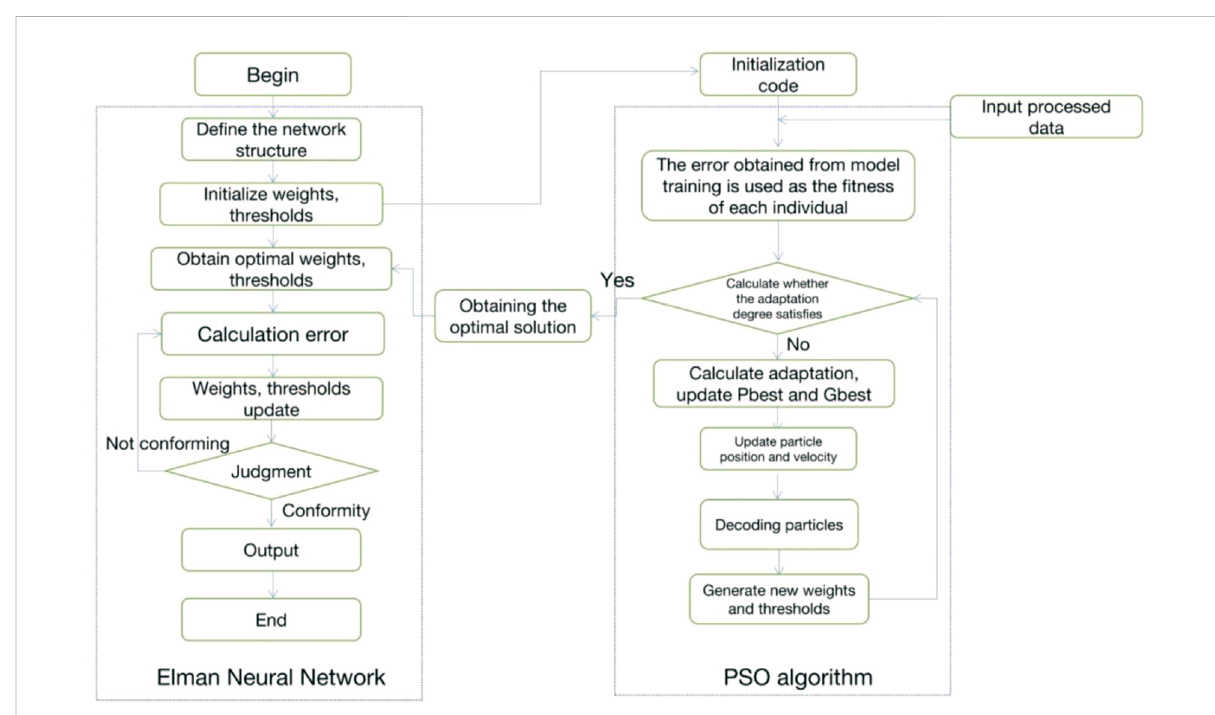
FIGURE 4 Optimisation of Elman Neural Network (ENN) using Particle Swarm Optimisation